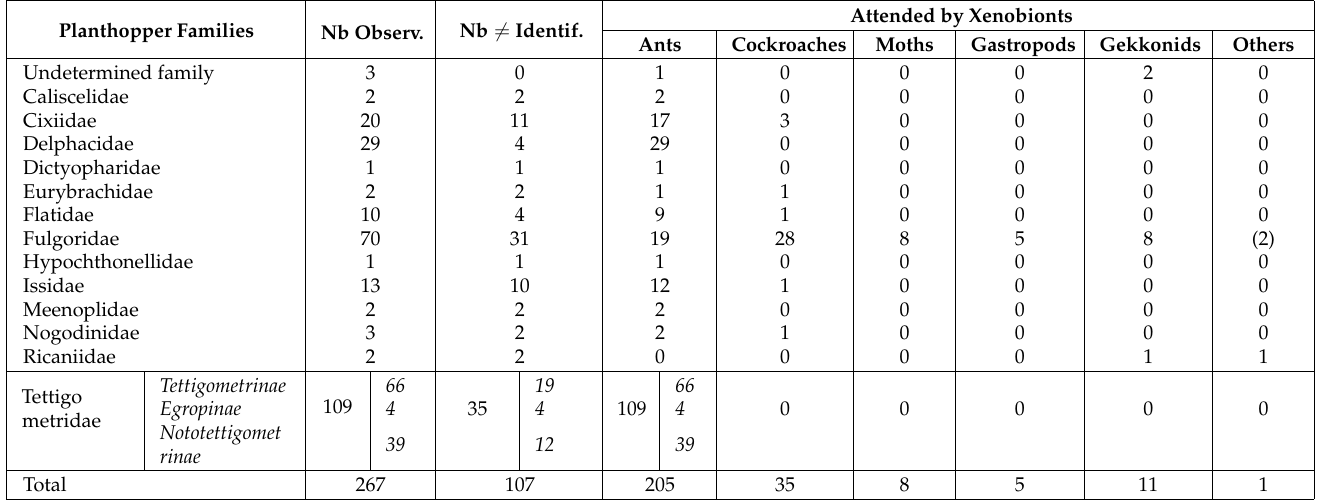
Table 1. Numbers of trophobiosis observations (distinct trophobiont-xenobiont pairs) reported by planthoppers families, for identified planthopper taxa (at least to genus level), and by xenobiont taxa. For Tettigometridae, figures are also reported by subfamilies. In brackets: 2 probably non-true trophobiosis